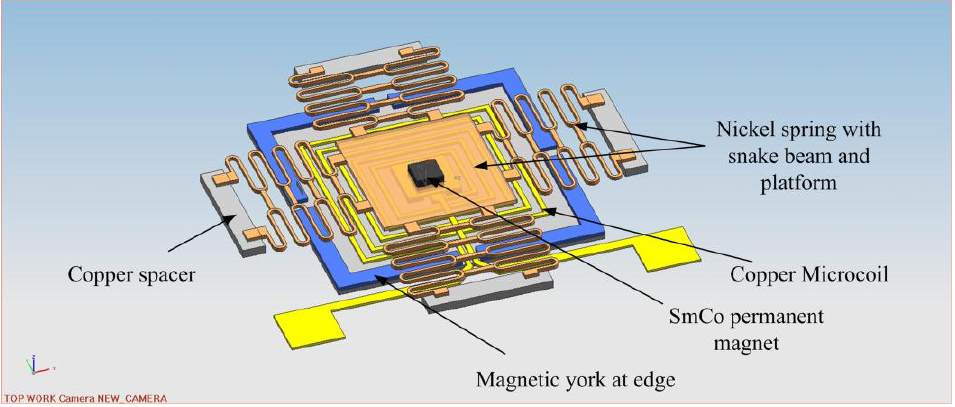
Figure 1. 3D model of the electromagnetic bistable microswitch.